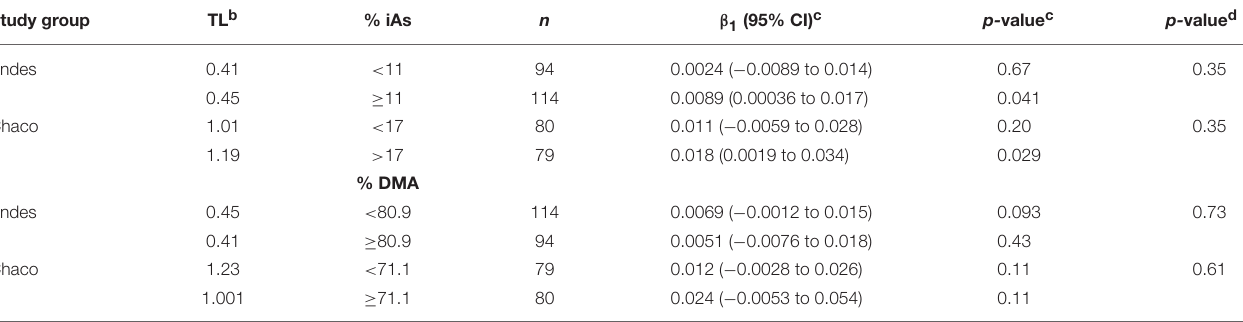
TABLE 4 | Multivariable regression analyses of the associations between U-As and telomere length stratified for arsenic metabolism efficiency (above and below median of fraction of each metabolite) a . Study group TL b % iAs n β 1 (95% CI) c p- value c p- value d Andes 0.41 < 11 94 Chaco 1.01 % DMA Andes 0.45 < 80.9